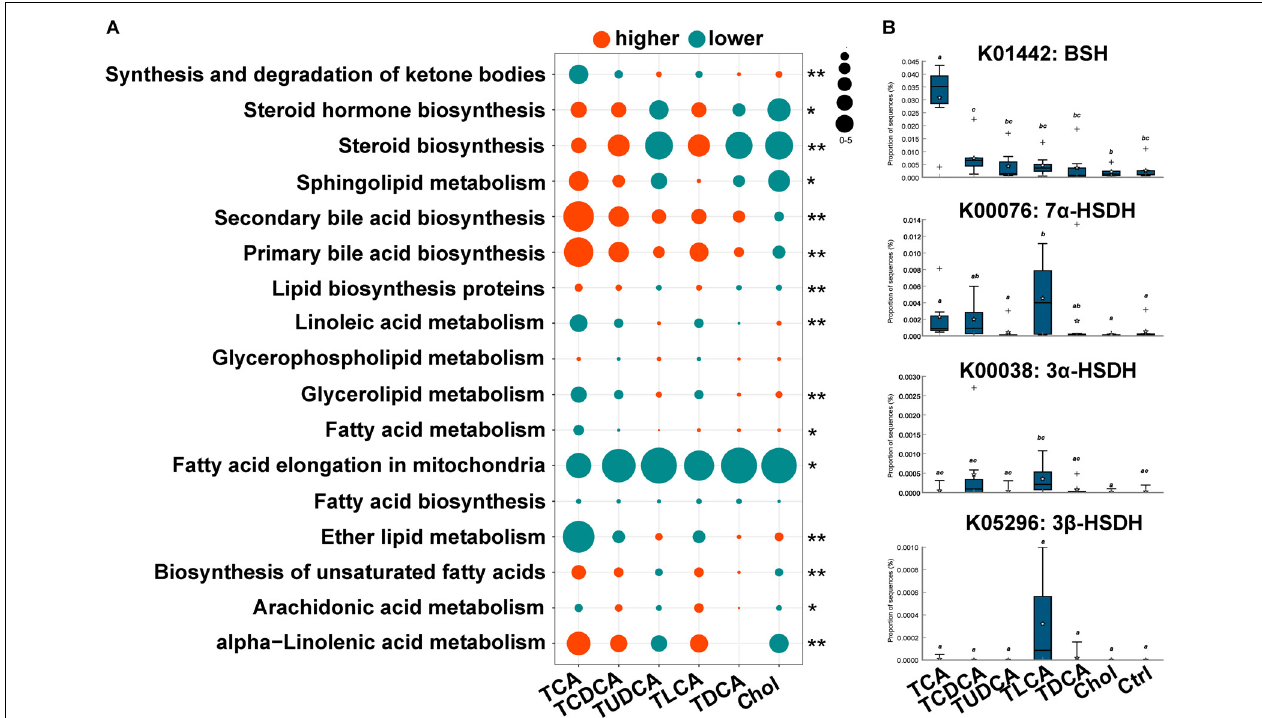
FIGURE 4 | Changes in KEGG pathway and candidate genes between gut microbiota in the six experimental groups and the control group, predicted by PICRUST. (A) Changes in KEGG pathways associated with lipid metabolism. For each pathway in each group, log2 value of the proportion of functional shift is shown (represented by circle size and color). Net positive shifts (red) indicate increased pathway activity (higher) in a group. Net negative shifts (green) indicate lower pathway activity (lower) in a group. The size of circle corresponds to the magnitude of the shift. P -value was calculated using the nonparametric Kruskal–Wallis test correcting for multiple comparisons with the Benjamini–Hochberg false discovery rate (FDR); 0.001 < P < 0.05 values are marked with “ ∗ ” and P = 0.001 values with “ ∗∗ ”. (B) The relative abundance of four candidate genes involving in BA biotransformation of gut microbiota. Different letters above bars indicate statistically significant ( P < 0.05) differences between groups. Groups not sharing the same lowercase letter are significantly different ( P <